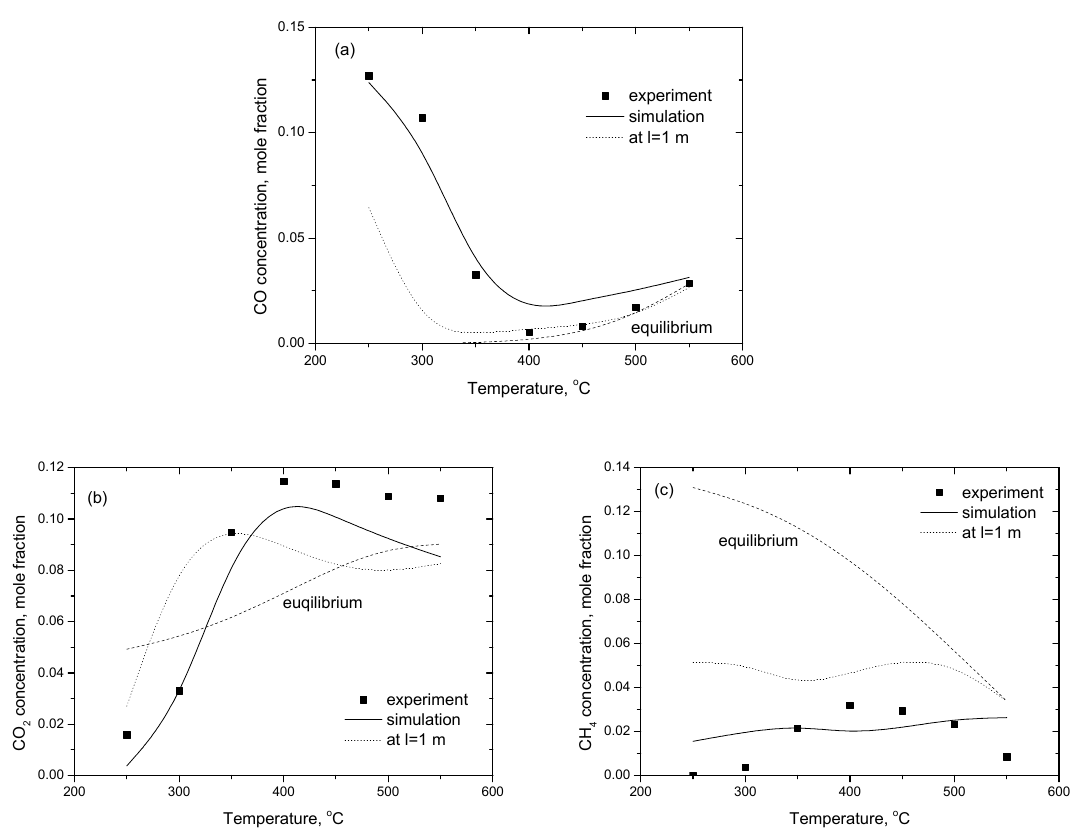
Figure 16. Comparison of experimentally and numerically predicted concentrations for WGS over the 12.5% Ni/CeO 2 catalyst and equilibria for the given feed mixture as a function of temperature: ( a ) CO, ( b ) CO 2 , ( c ) CH 4 (feed stream—14.29% CO + 28.57% H 2 O + 28.57% H 2 in N 2 ).